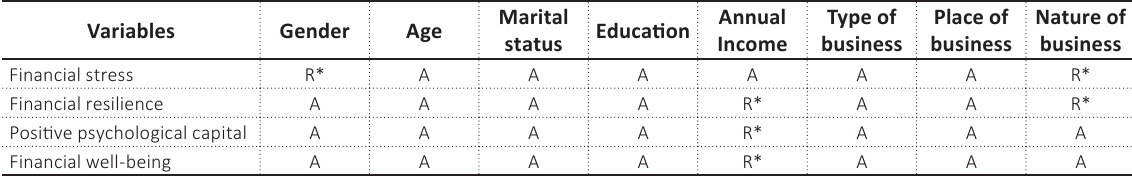
Table 1. Differences in personal and business-related characteristics